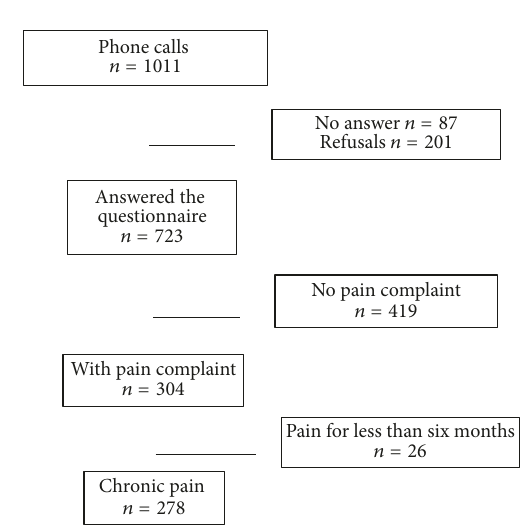
Figure 1: Study design